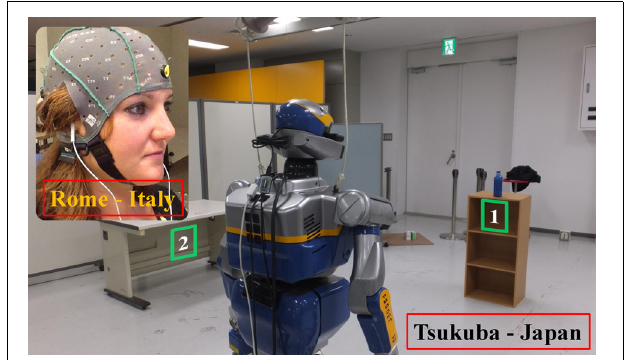
FIGURE 1 | Participants located in Rome (Italy) controlled an HRP-2 humanoid robot located in Tsukuba (Japan) by a SSVEPs-BCI system. The subjects guided the robot from a starting position to a fist table (marked in green as “1”) to grasp the bottle and then drop the bottle as close as possible to a target location marked with two concentric circles on a second table (marked in green as